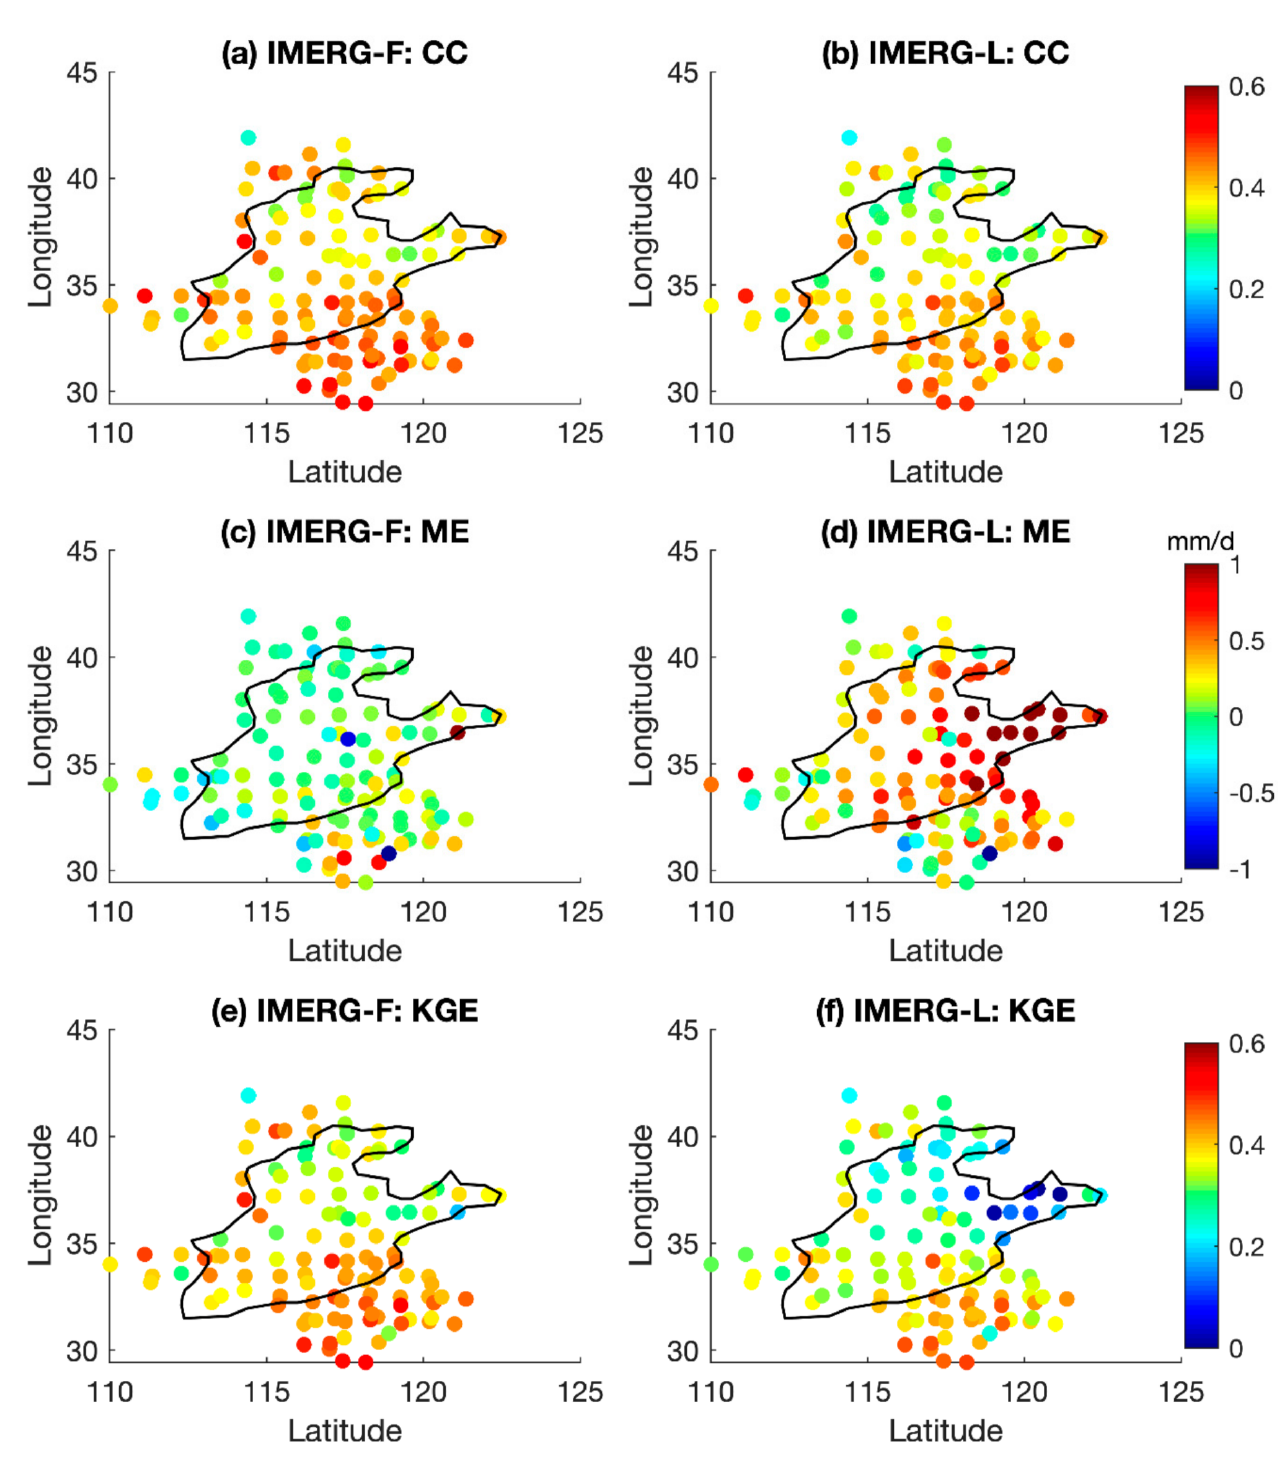
Figure 5. The distributions of three metrics CC, ME, and KGE for the IMERG-F and IMERG-L precipitation products at the daily